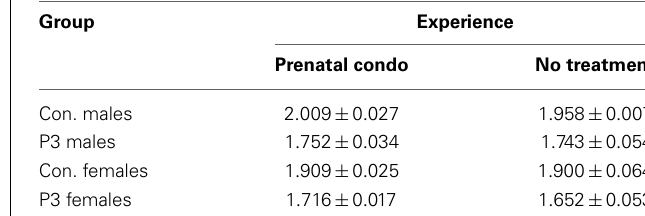
Table 2 | Summary of brain weight.